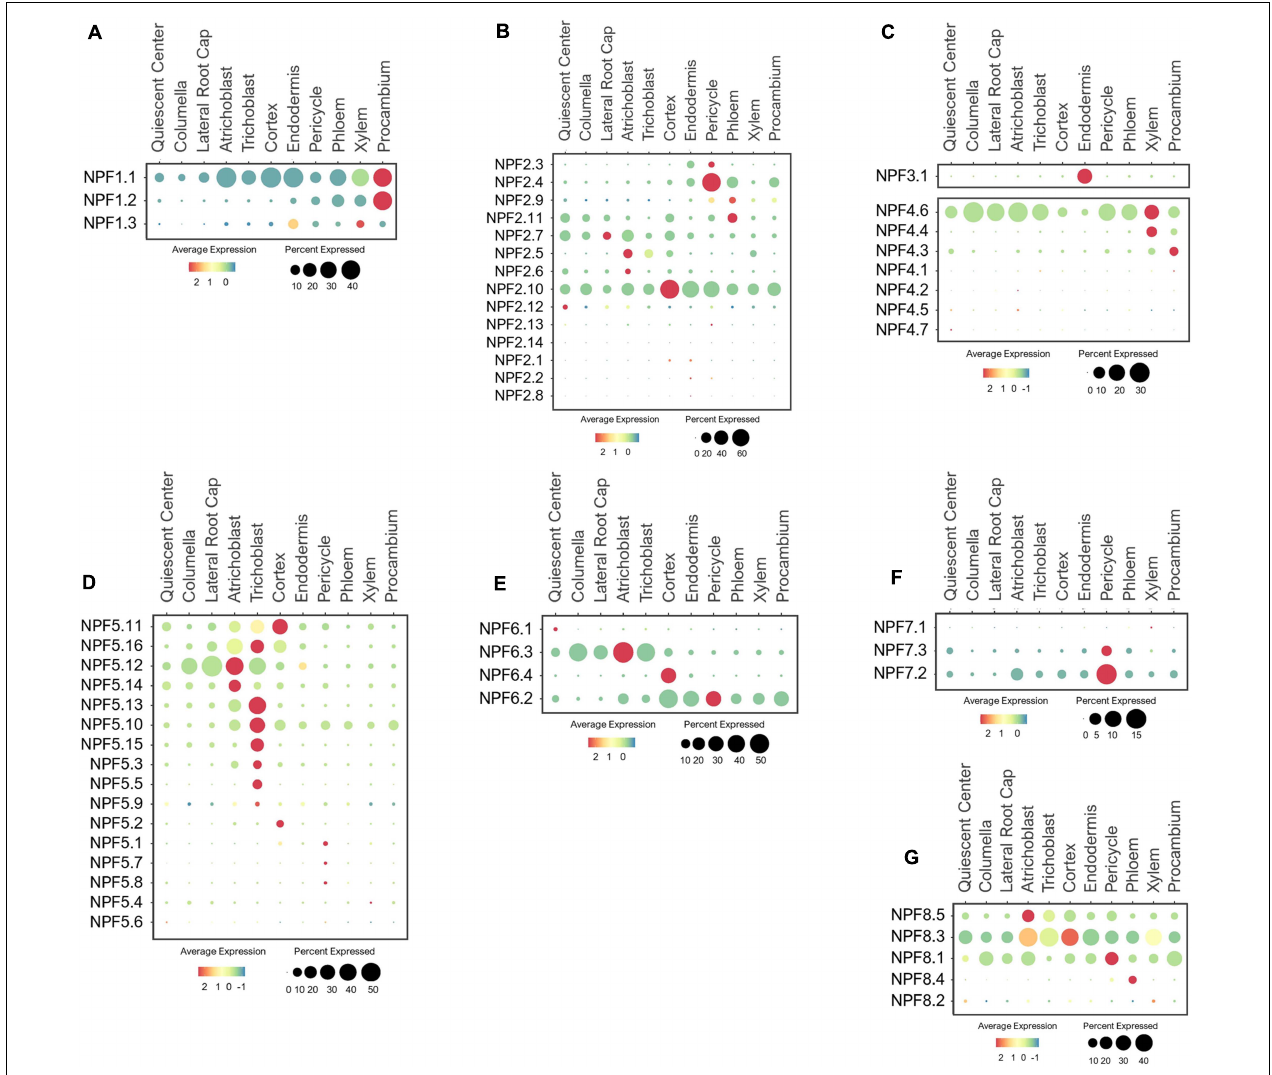
FIGURE 2 | Expression of the low-affinity NPF transporters in Arabidopsis root single cells, (A,B) NPF1-2, (C) NPF3/4, and (D–G) NPF5-8. In dot plots, the circle size represents the proportion (%) of cells expressing a given gene, and the color of scale bar represents the mean expression (natural log +1